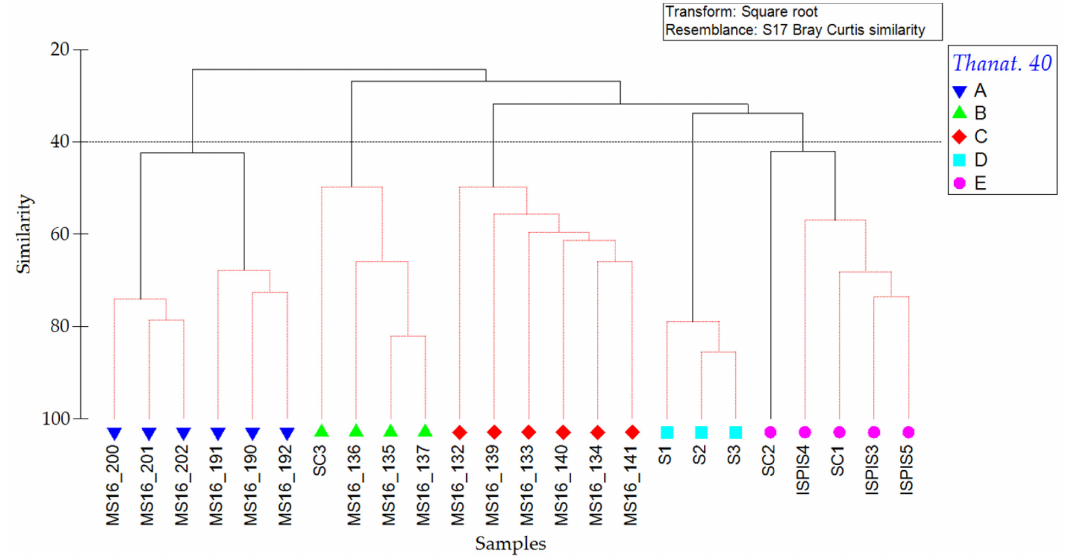
Figure 5. Dendrogram based on dataset Reduction 2. Similarity cut at 40%; it identifies five thanato- coenoses